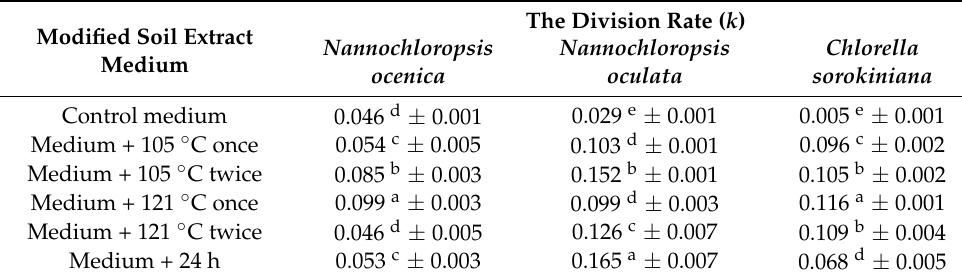
Table 5. The division rate, k of Nannochloropsis ocenica , Nannochloropsis oculata , and Chlorella sorokiniana in different modified soil extract